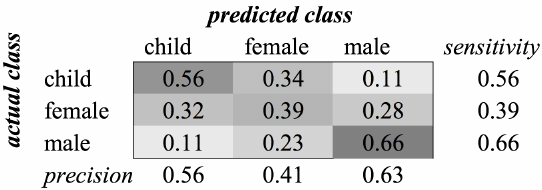
Figure 3. Classification of category Gender using SVM on time domain (TD) + frequency domain (FD)